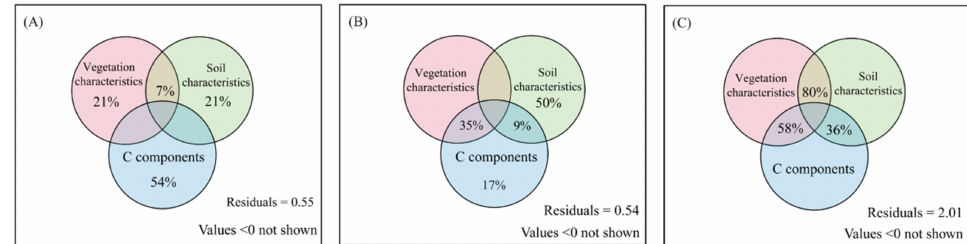
Figure 4. Variation partitioning analysis (VPA) displaying the effects of soil physicochemical proper- ties, vegetation characteristics, and C components on soil microbial CUE in macro-aggregates ( A ), medium aggregates ( B ), and micro-aggregates ( C ). During data analysis, species number, H, litter, and biomass were used for vegetation characteristics; pH, SBD, NO 3 − -N, NH 4+ -N, and AP were used for soil characteristics; DOC, MBC, and LOC were used for carbon